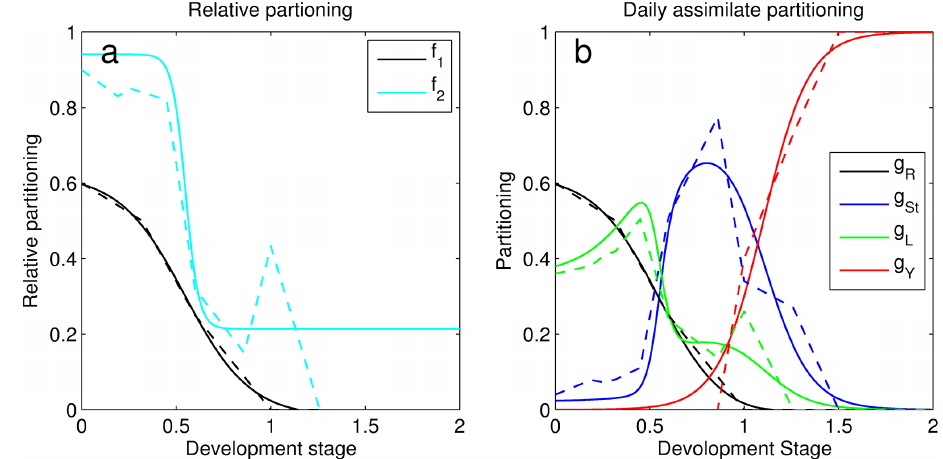
Figure A1. (a) The allocation to roots relative to vegetative organs ( f 1 ) and the allocation to leaves relative to leaves and stem ( f 2 ) for spring wheat. Dashed lines represent the allocation model from Penning de Vries et al. (1989) and solid lines are fitted Richards equations (Eqs. 3 and 4). (b) The resulting allocation scheme to roots ( g R ), stem ( g St ), leaves ( g L ) and grains ( g Y ) (solid lines) compared to data from Penning de Vries et al. (1989) (dashed lines) from equations in Eq. (6).